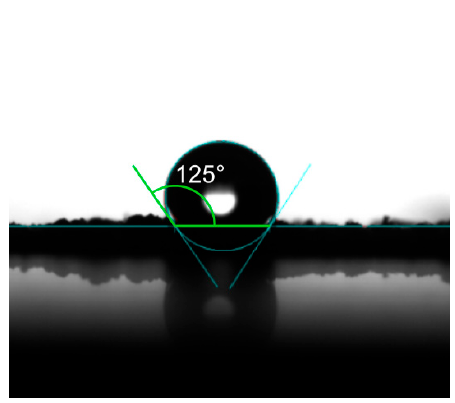
Figure 7. Contact angle measurement of EP-POSS.